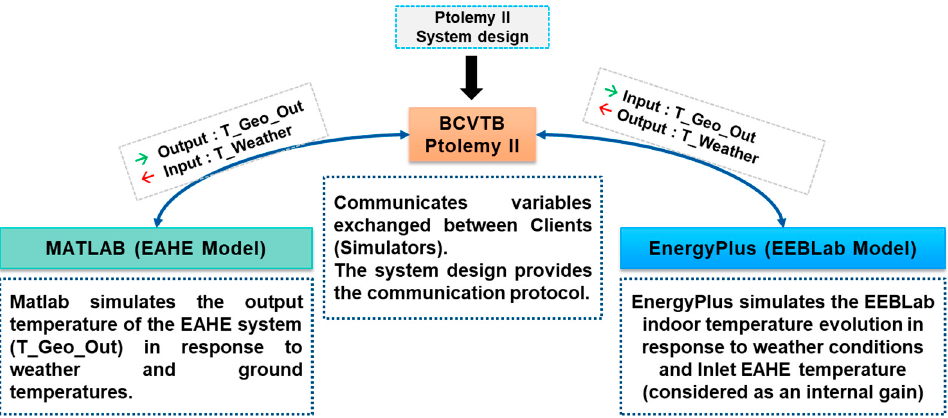
Figure 15. Communication architecture and data exchange between simulators and Ptolemy II BCVTB.